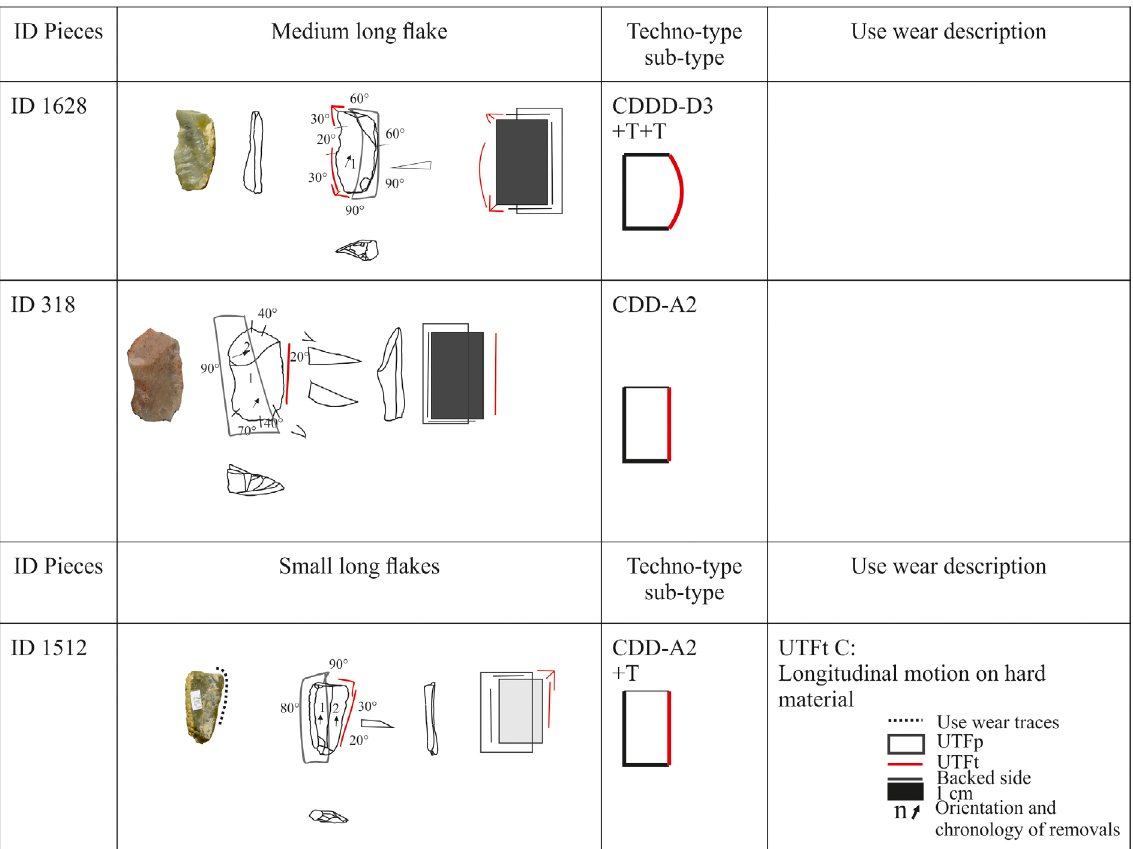
Figure 12. Techno-functional analysis and description of use wear traces of the medium long flakes and small long